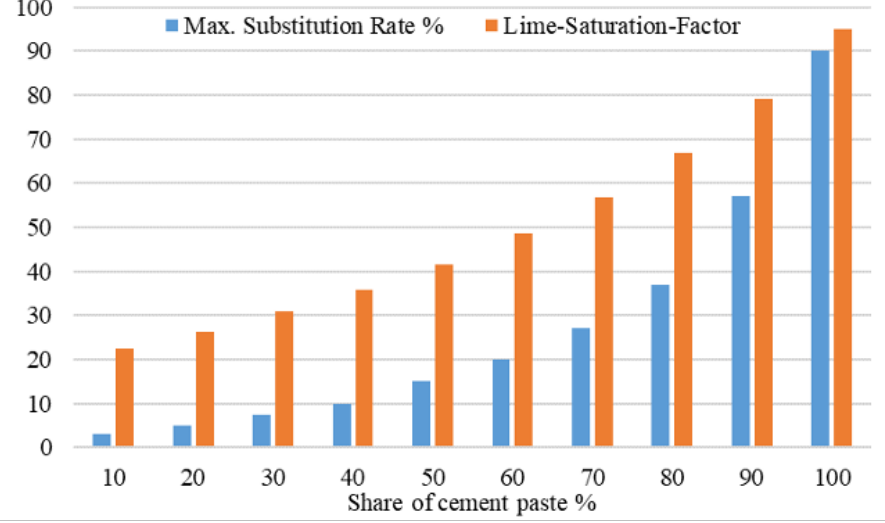
Figure 4. Maximum substitution rate depending on Lime-Saturation-Factor